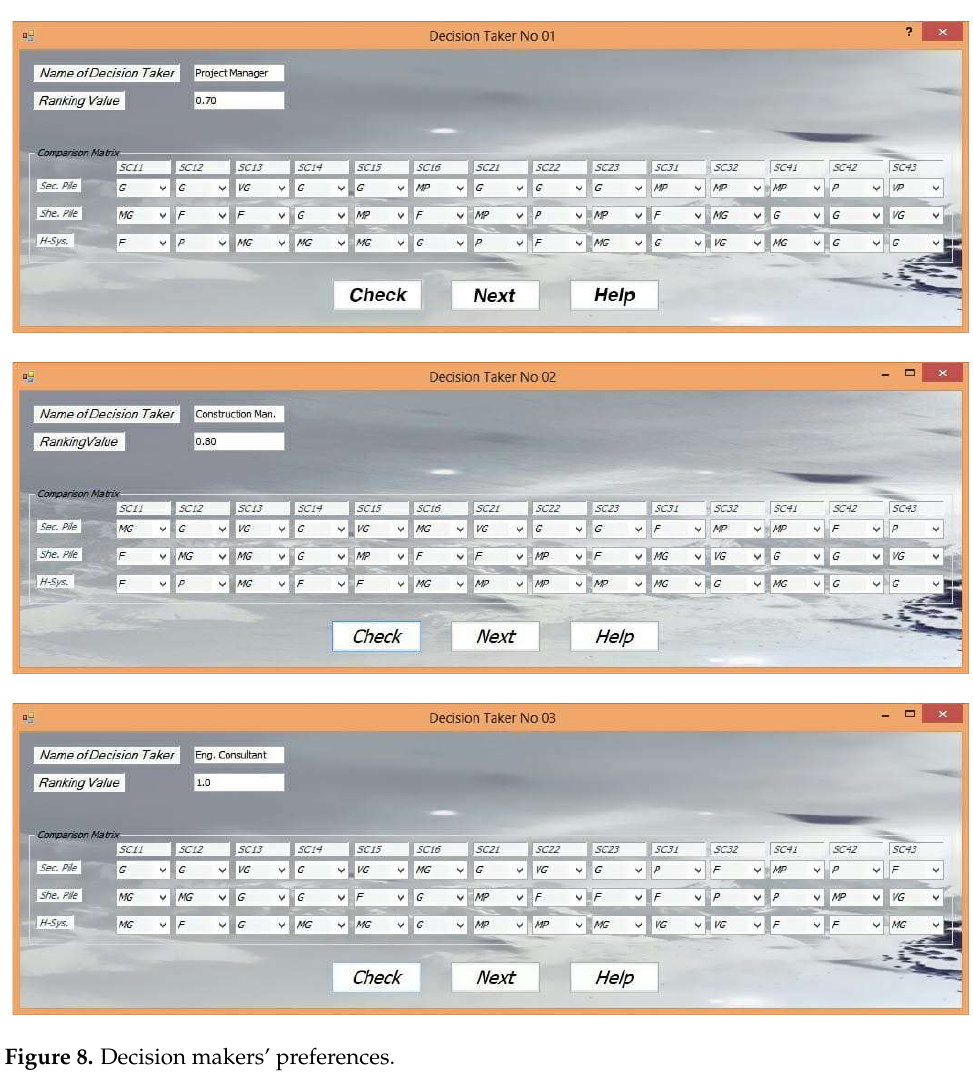
Figure 8. Decision makers’ preferences.